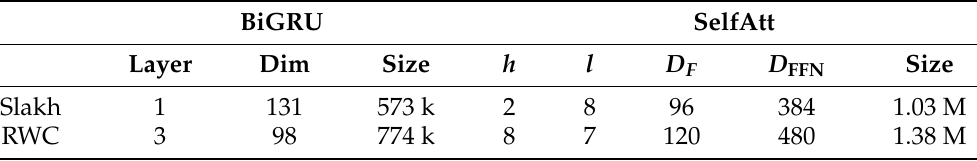
Table 1. Hyperparameters of the decoders of the two transcription models optimized by Optuna.